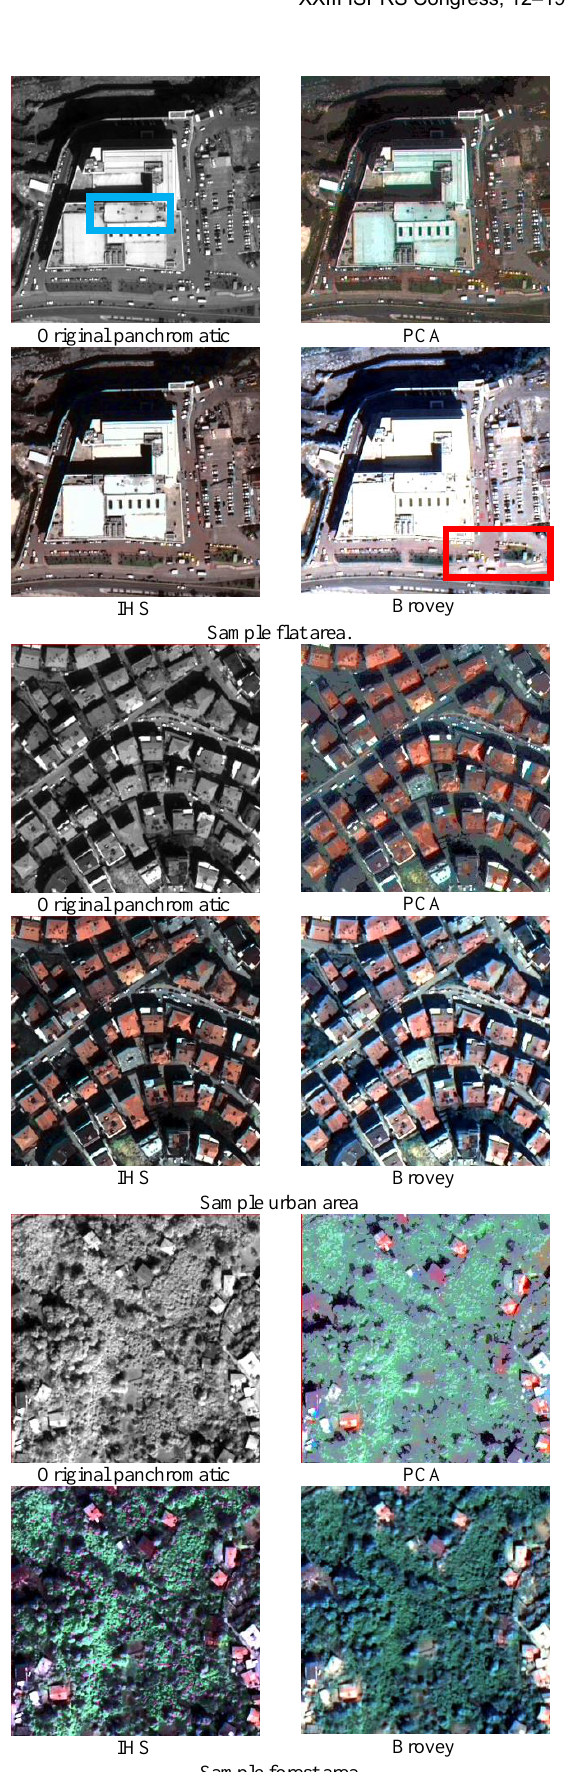
Figure 9. Sample areas for qualitative